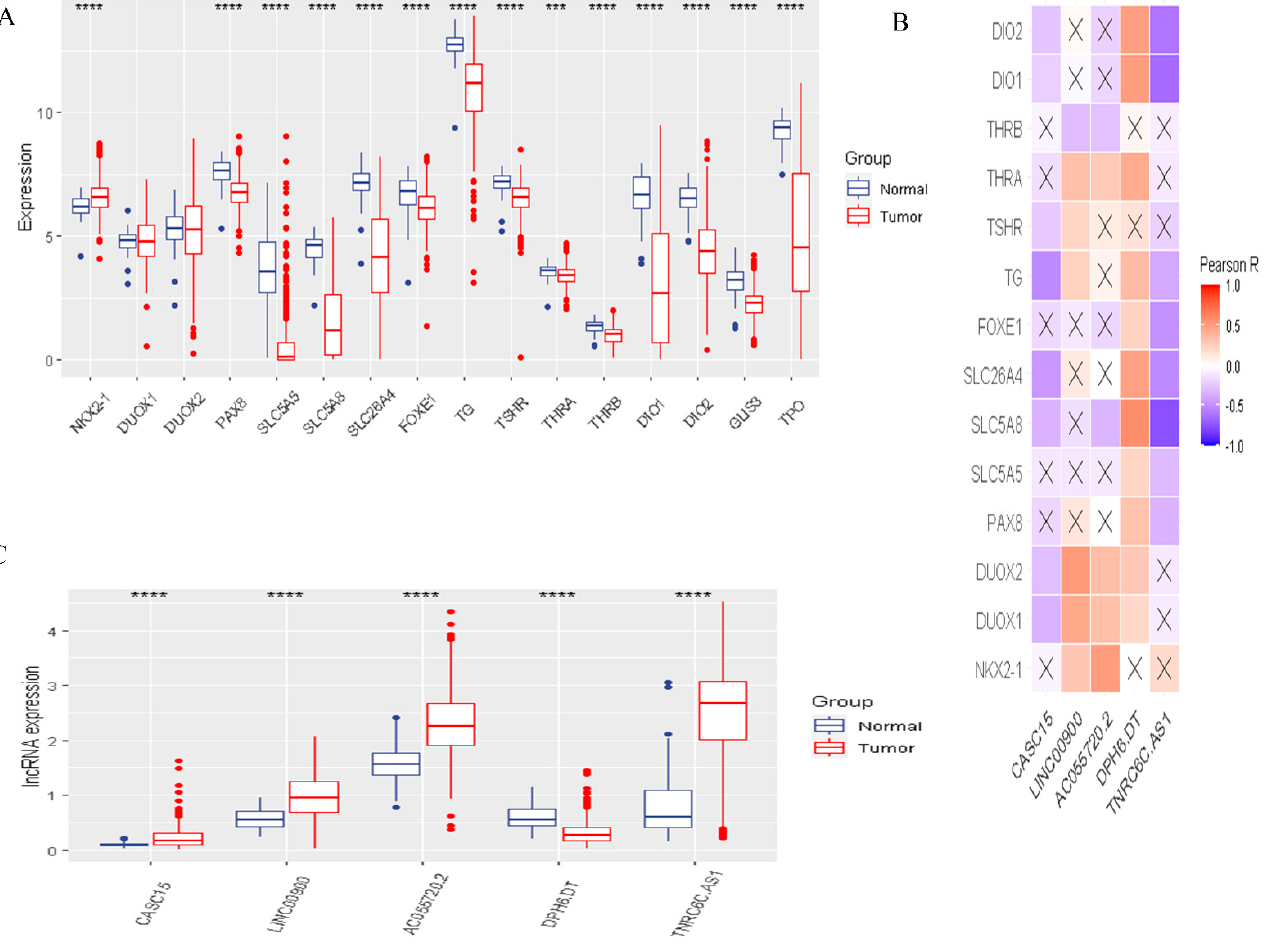
Figure 2. The landscape of DR ‐ lncRNAs regulators. ( A ) Expression of 16 differentiation related reg ‐ ulators and DR-lncRNAs. ( C ) Differential expression of 5 DR-lncRNAs regulators. *** p < 0.001, ulators in normal and tumor samples; ( B ) The relationship between differentiation ‐ related regula ‐ **** p < tors and DR ‐ lncRNAs. ( C ) Differential expression of 5 DR ‐ lncRNAs regulators. *** p < 0.001, **** p < 0.0001.